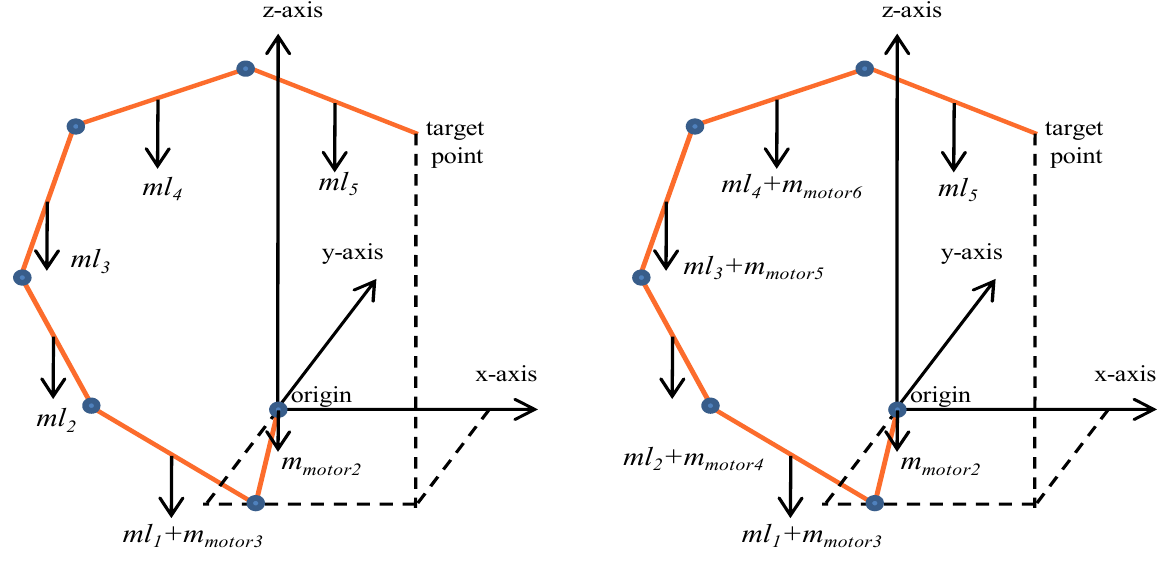
Figure 9. The position of mass for ( a ) the proposed manipulator; ( b ) the conventional